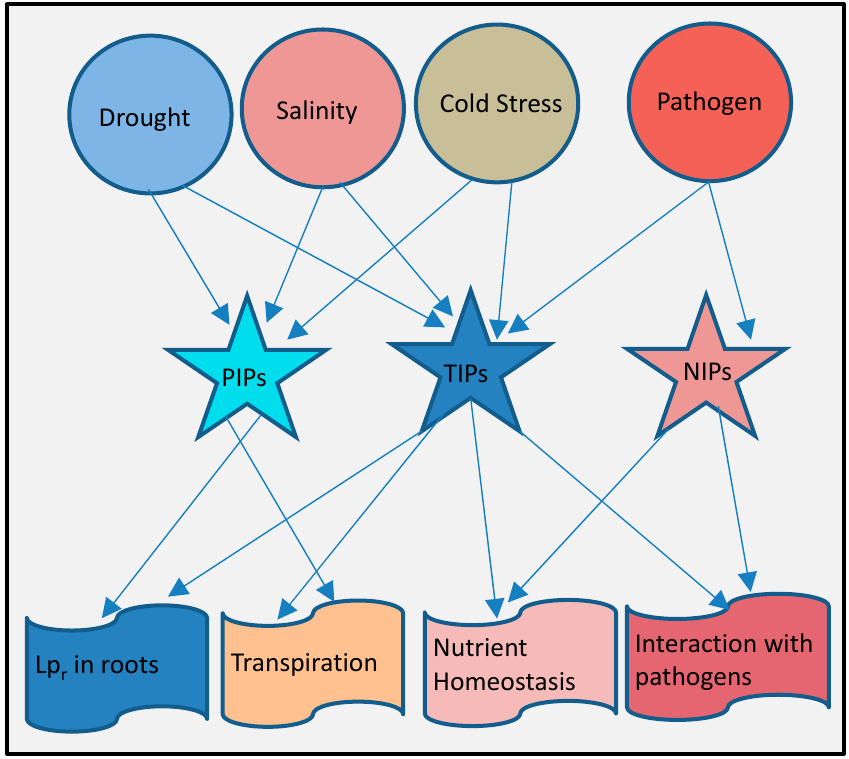
Figure 3. A generalized summary of plant aquaporins in response to environmental stimuli. Both PIPs and TIPs are more responsive to drought, salt and cold stress that disturb cell osmotic balance, they regulate root hydraulic conductivity ( L p r ) and transpiration rates. TIPs along with NIPs are involved in biotic stress responses and involved in regulating nutrient homeostasis between host and its pathogen. NIPs and TIPs are also found to interact with some pathogen proteins.